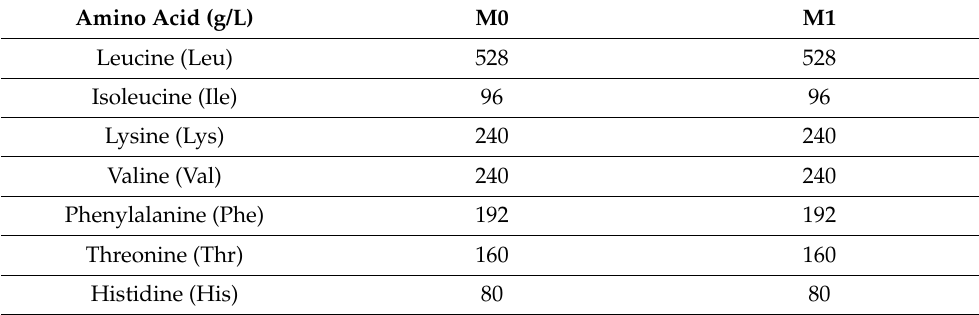
Table 1. Amino acid concentrations in the experimental media